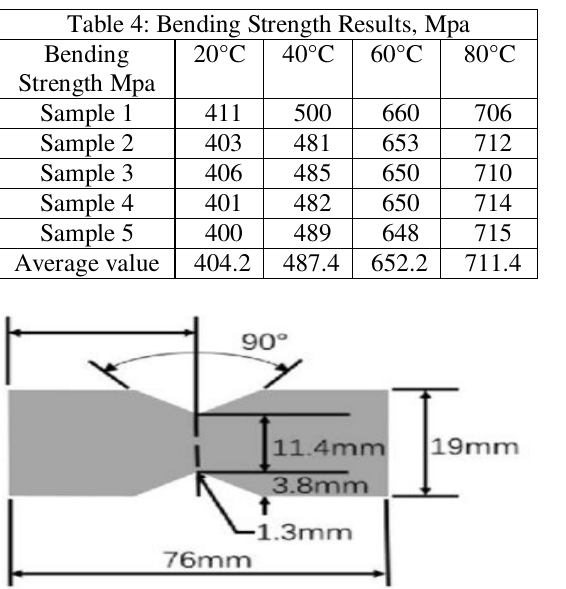
Table 4: Bending Strength Results, Mpa